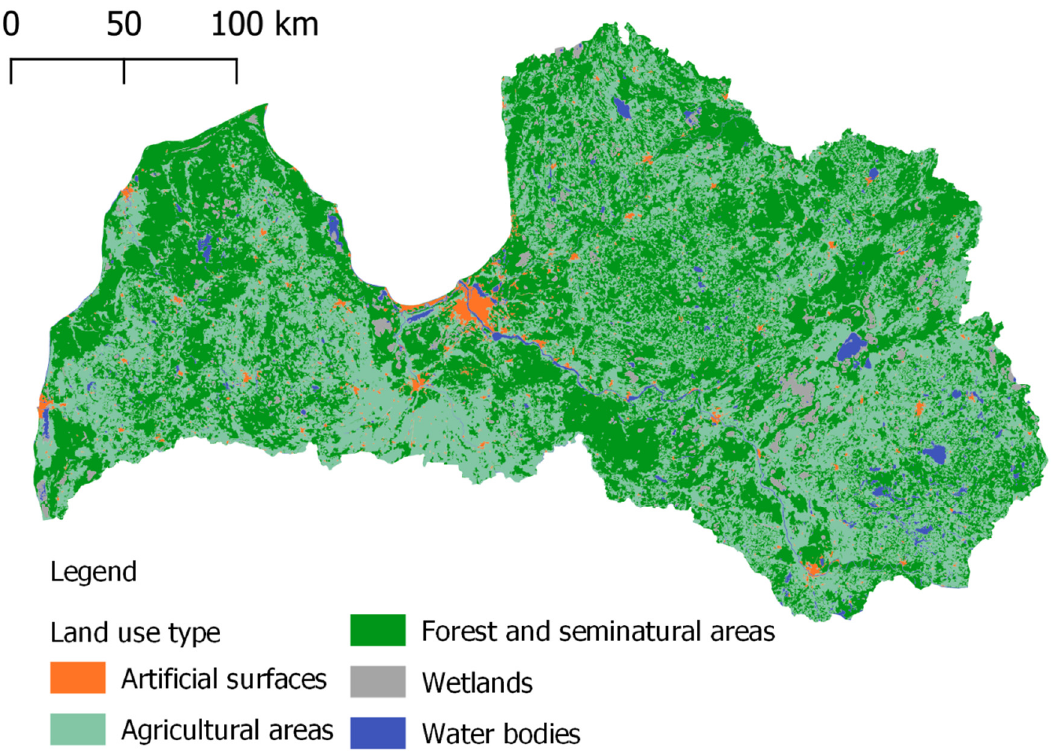
Figure A1. Land-use map of Latvia based on CORINE land-cover Figure A1. Land ‐ use map of Latvia based on CORINE land ‐ cover data.